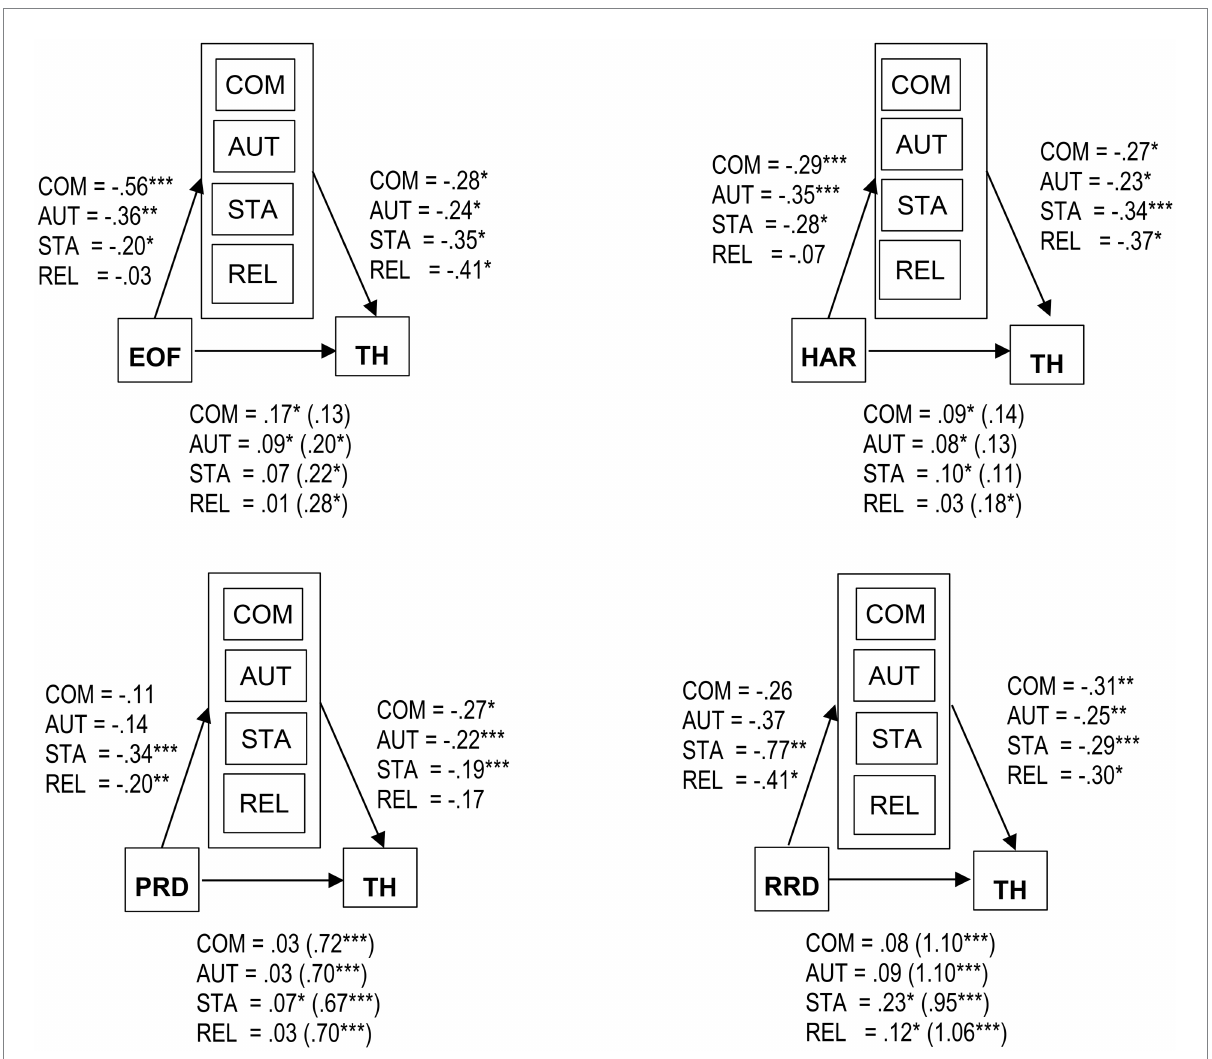
FIGURE 3 Indirect and direct effects in parentheses from mediation analyses for the trigger-needs-threat relationships. TH, threat; EOF, experience of failure; HAR, hindered action regulation; PRD, performance-related disrespect; RRD, relationship-related disrespect; COM, need for competence; AUT, need for autonomy; STA, need for status; REL, need for relatedness. * p < 0.05; ** p < 0.01; *** p <